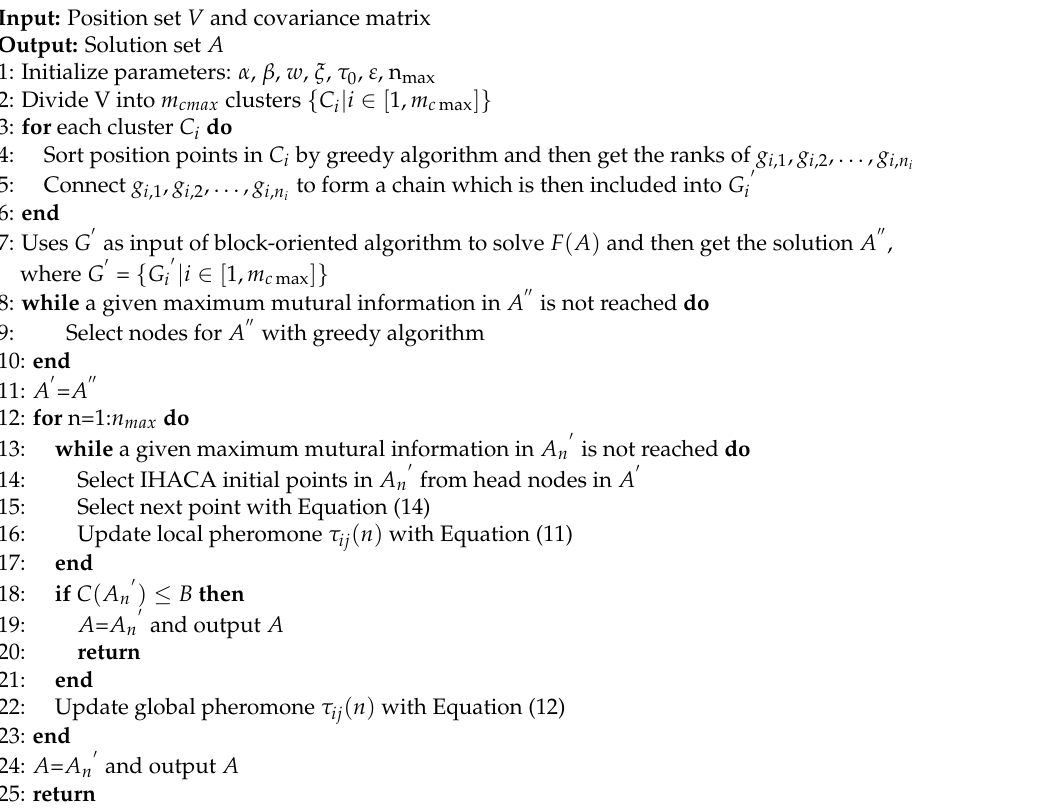
Algorithm 1 Improved Heuristic Ant Colony Algorithm-Chaos Optimization of Padded Sensor Placements at Informative and cost-Effective Locations